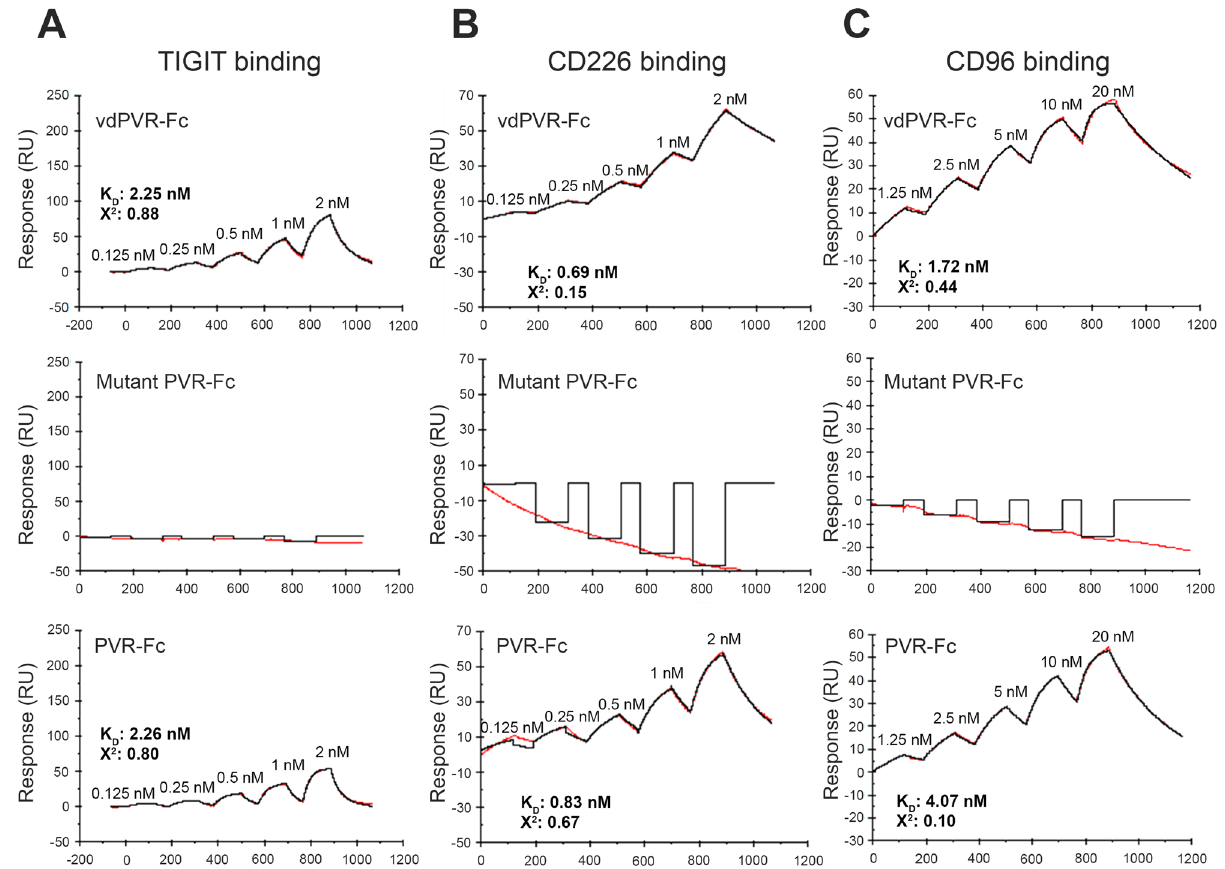
Figure 2. Surface plasmon resonance (SPR) titration profiles of vdPVR-Fc, mutant vdPVR-Fc and PVR-Fc binding to mouse TIGIT, mouse CD226 and mouse CD96. (A-C) SPR single-cycle kinetics sensorgrams (in red) and fitted curves (in black) with equilibrium association (K D ) constant showing the binding of vdPVR-Fc, mutant vdPVR-Fc and full length PVR-Fc to immobilized recombinant (A) mouse TIGIT-Fc-his, (B) mouse CD226-his and (C) CD96-his. Five concentrations (indicated on the sensorgrams) of vdPVR-Fc, mutant vdPVR-Fc and PVR-Fc were flown over the immobilized recombinant proteins. Kinetic parameters were calculated from 1:1 Langmuir binding model using Biacore evaluation software.